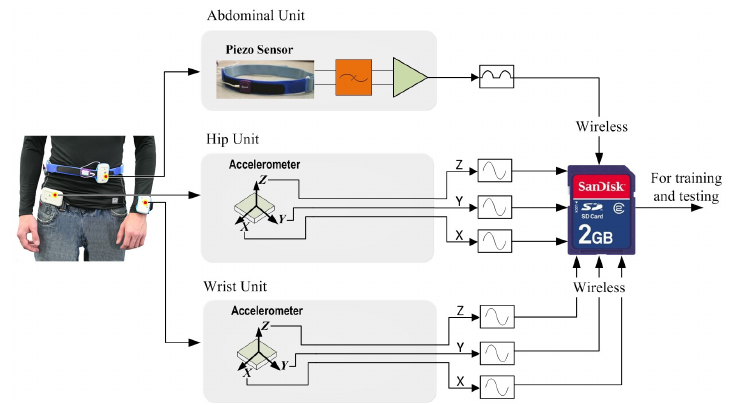
Figure 3. The setup of the WIMS.